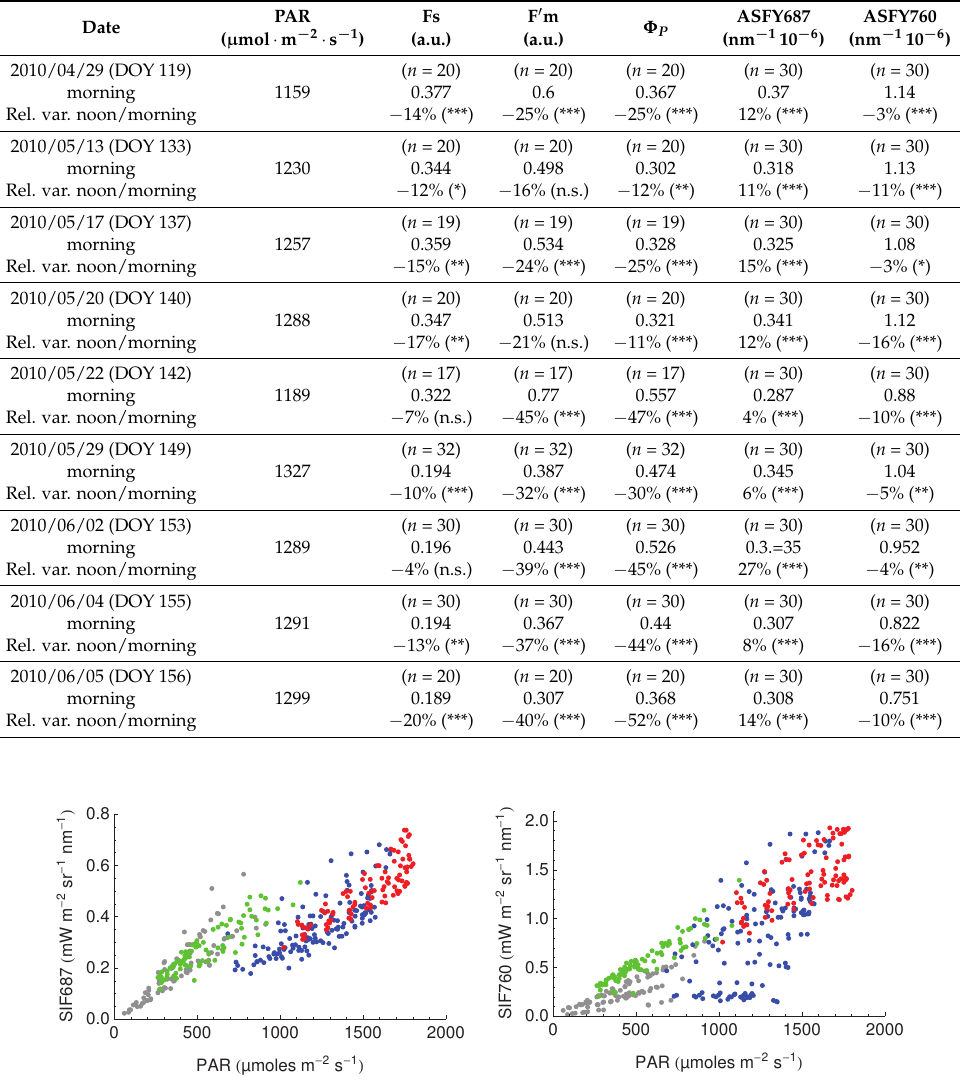
Table 2. Changes of fluorescence between morning ( 8:00 UTC) and noon ( 12:00 UTC) on sunny days. Fs: mean leaf fluorescence level measured with a PAM-2000; F (cid:48) m: maximum fluorescence level of leaf upon a saturating pulse; Φ P : leaf photochemical yield; number of samples as indicated; ASFY687 and ASFY760, apparent spectral fluorescence yield at 687 and 760 nm defined as the ratio between fluorescence radiance and incident PAR. Mean values between 8:00 and 8:30 (morning) and 12:00 and 12:30 (noon) are reported. Significance levels are indicated: n.s., * p < 0.05, ** p < 0.01, *** p < 0.001. The measuring distance on the leaf-clip was modified on DOY 149, so Fs and F (cid:48) m measurements between DOYs 119–142 and DOYs 149–156 are not comparable.